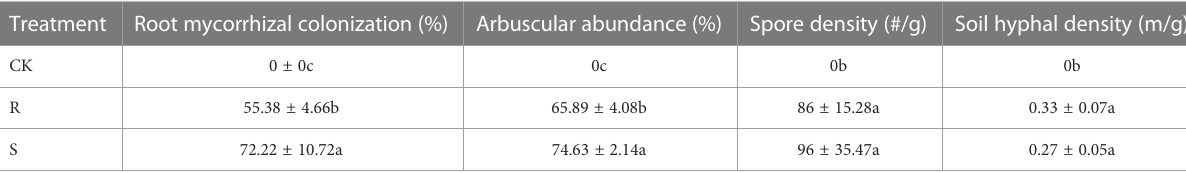
TABLE 1 The mycorrhizal propagation performance between R and S treatment in white clover root and rhizosphere.